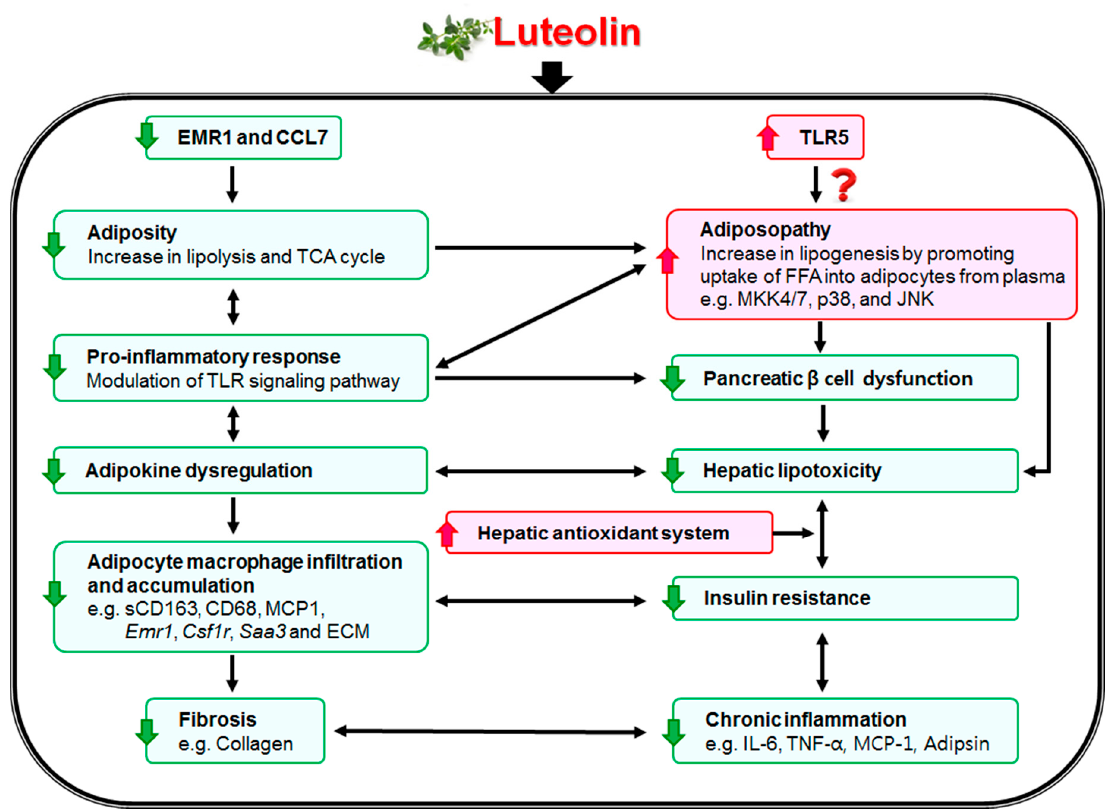
Figure 7. Proposed role of luteolin in attenuating hepatic and adipocyte fibrosis and insulin resistance by targeting the Toll-like receptor signaling pathway in high-fat-fed mice. Luteolin improved chronic low-grade inflammation by modulating the TLR signaling pathway, resulting in suppression of hepatic and adipocyte fibrosis by decreasing pro-inflammatory cytokines, adipokine dysregulation, macrophage and extracellular matrix accumulation, and captesin gene expressions. Interestingly, Emr1 and Ccl7 , important markers inducing low-grade inflammation, were affected by advanced age and greater body weight, which were normalized by luteolin treatment. Moreover, luteolin prevented hepatic lipotoxicity via an increase in uptake of FFA into adipocytes from plasma [29] and the hepatic antioxidant system, which was linked to activation of lipogenesis in adipose tissue mediated via Tlr5 , Map2k7 , Mapk12 , Mapk13 , and Mapk9 gene expressions; further, Tlr5 may be a key transcription factor for luteolin-mediated lipotoxicity protection. Decreased plasma FFA levels by luteolin were associated with improved pancreatic islet dysfunction, which all contribute to improvement of lipotoxicity, fibrosis, and insulin resistance.